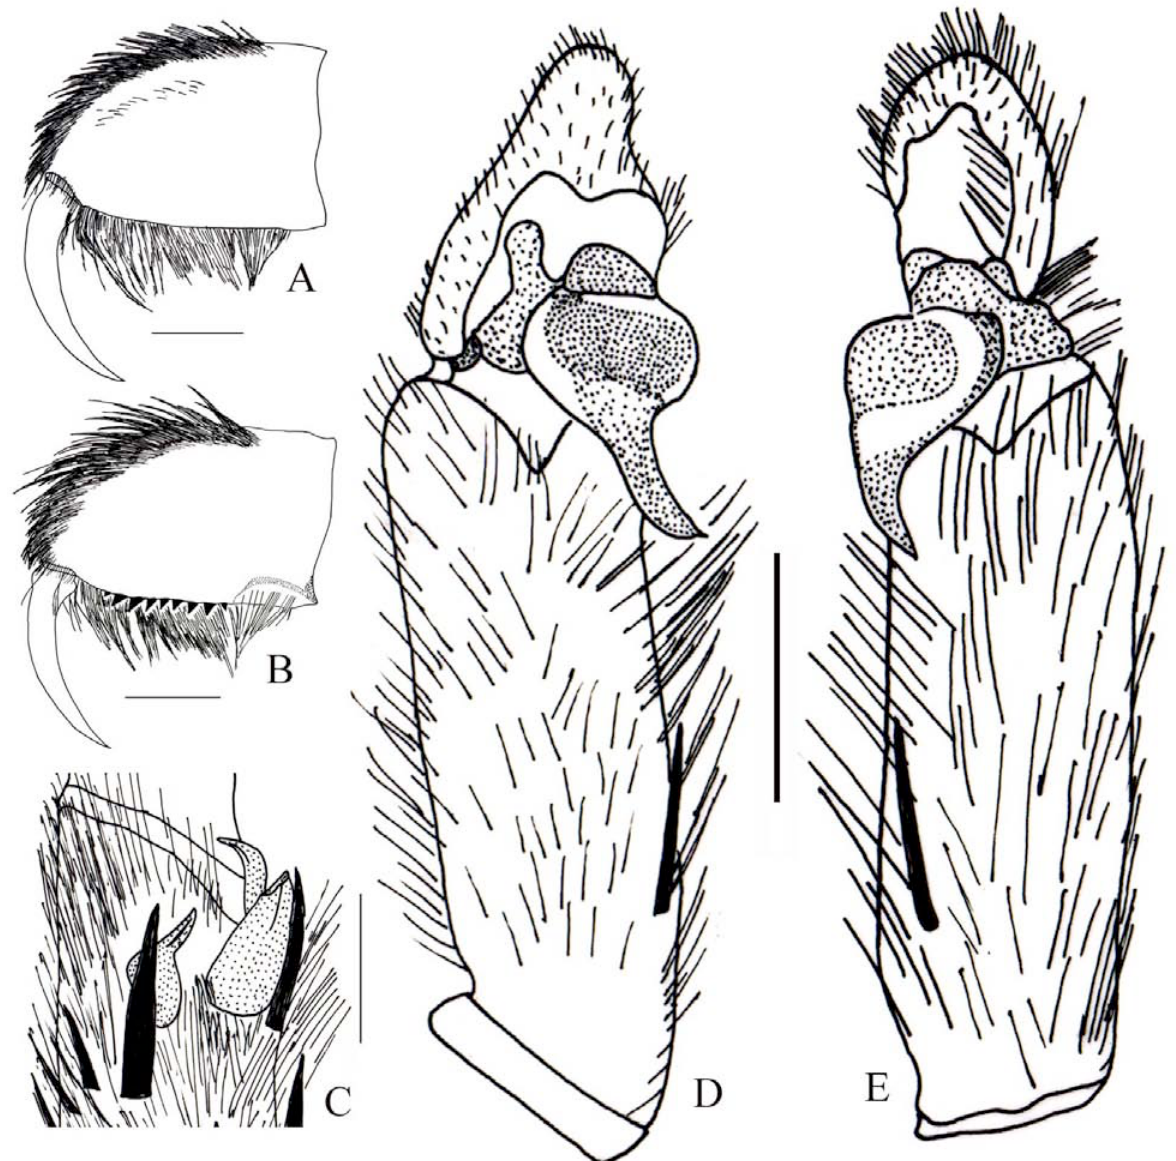
Figure 2. S. arthrapophysis male. A. Celicerae, retrolateral face. B. Celicerae, prolateral face. C. Tibial spurs. D. Palp, retrolateral view. E. Palp, prolateral view. (scale for C = 0.5mm; A, B, D, E = 1mm) (1915), and as more specimens become available the level of variation will reveal whether they are one or two species. Presently the specimens recorded were from different heights above sea level and 135km apart with difference in habitat